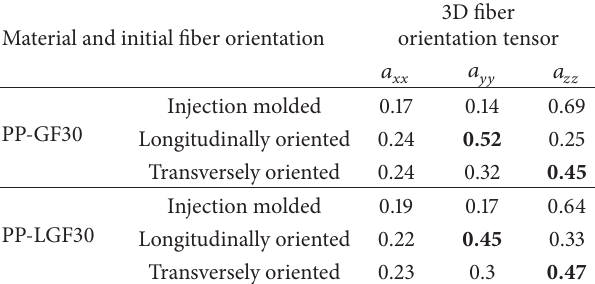
Figure11:Progressofthefiberorientationalongthe 𝑥 -and 𝑦 -axisin a plate of PP-LGF30 with initial fiber orientation being longitudinal to the joining direction (vibration welding). Table 2: Fiber orientation in parts to be joined by vibration